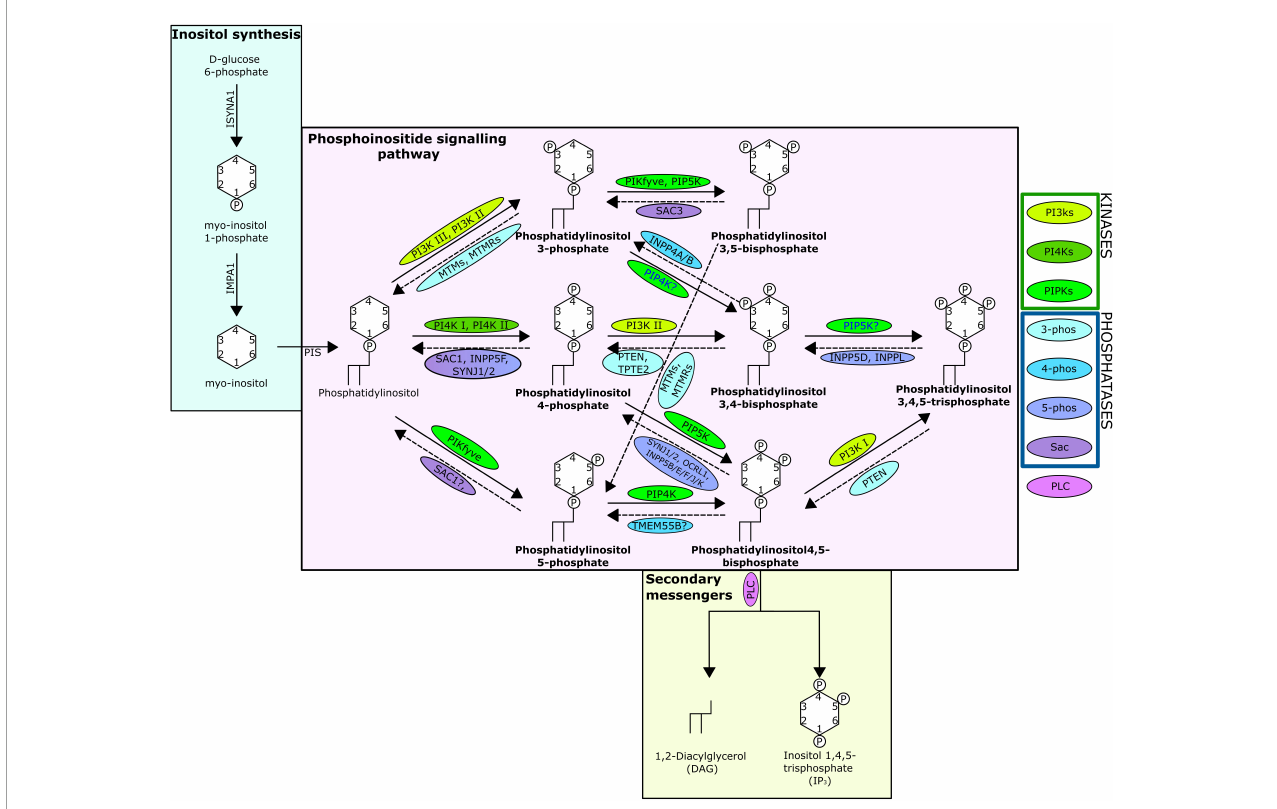
FIGURE1 The phosphatidylinositol pathway as known from human studies. Solid arrows indicate kinase action; dashed indicate phosphatase action. Arrows are labelled with the kinases/phosphatases responsible for the reaction, question marks show where there are ambiguities surrounding the reaction, and the proteins are surrounded with a bubble coloured to indicate protein grouping from the key. The seven PIPs are indicated in bold and the structure of the lipids including the location and number of phosphates are shown. The absence of INPP5A is due to evidence suggesting no lipid phosphatase action (Pathway specifics derived from Dickson and Hille, 2019; Nakada-Tsukui et al.,